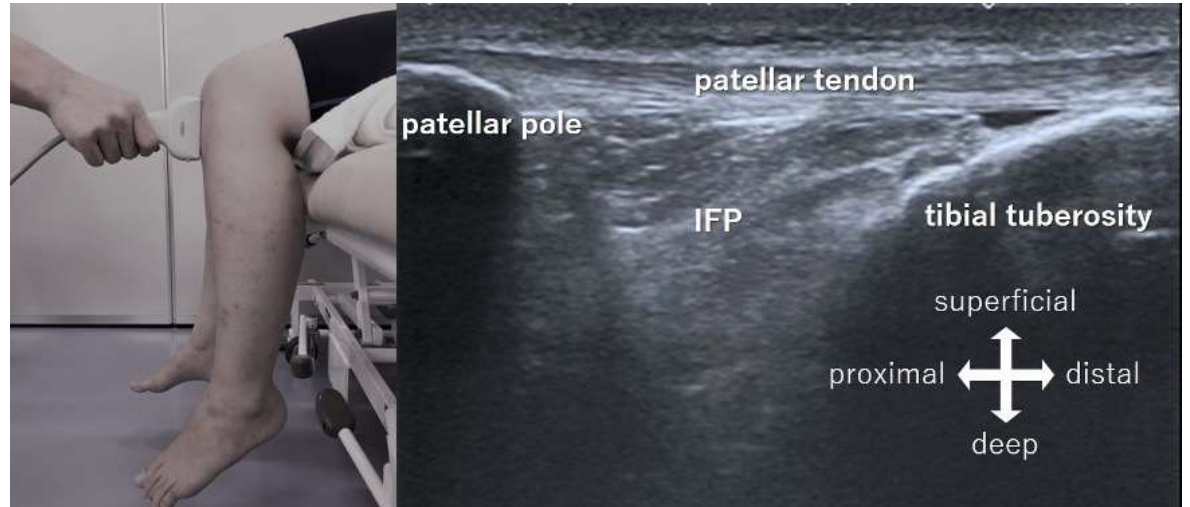
Figure 1. Ultrasound image capturing method. The probe was placed longitudinally at the center of the patellar tendon in the sitting position. IFP: infrapatellar fat pad.